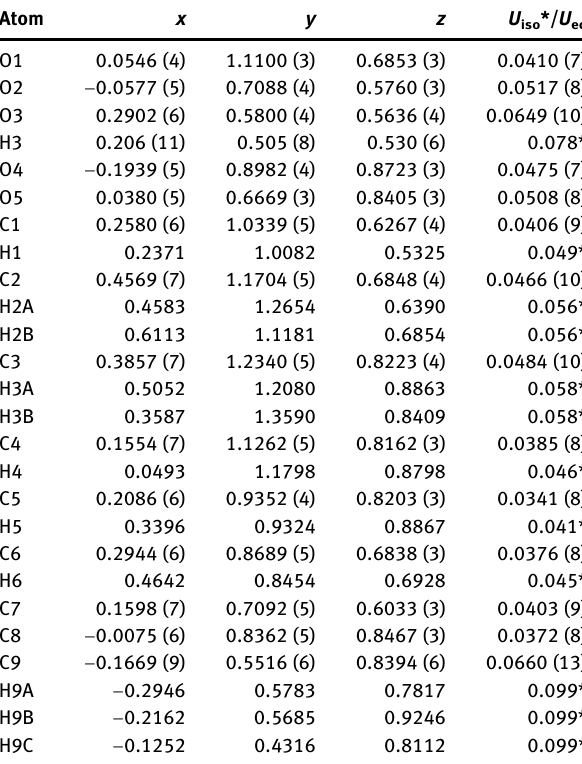
Table  : Fractional atomic coordinates and isotropic or equivalent isotropic displacement parameters (Å 